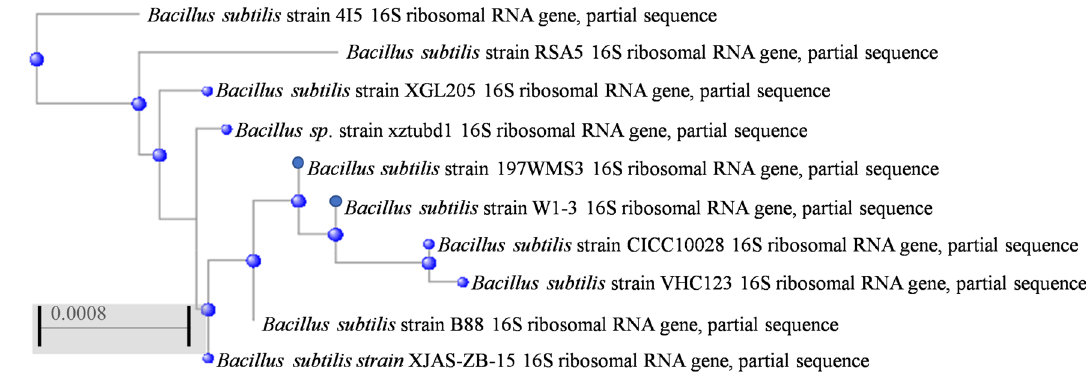
Figure 2. Phylogenetic tree of Bacillus subtilis xztubd1.